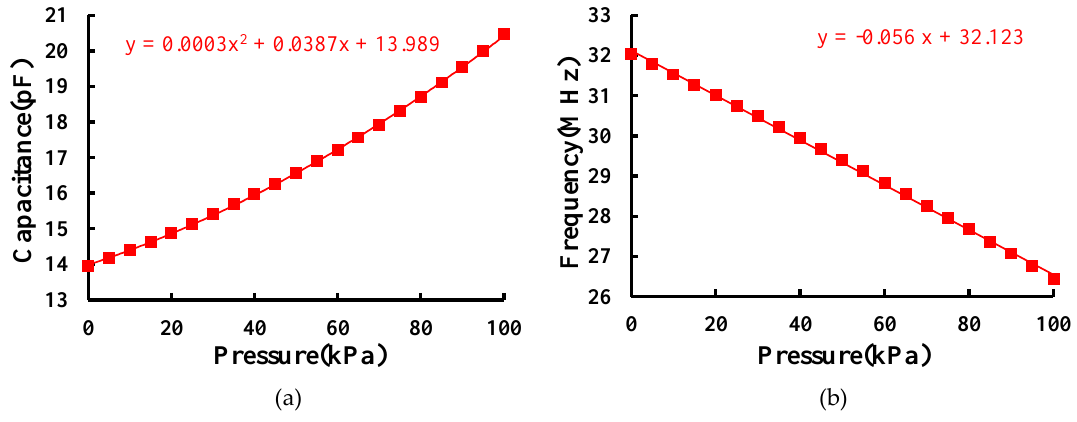
Figure 4 . (a) Capacitance vs pressure, (b) f0 vs pressure in simulation Figure 4. ( a ) Capacitance vs . pressure; ( b ) f 0 vs . pressure in simulation.